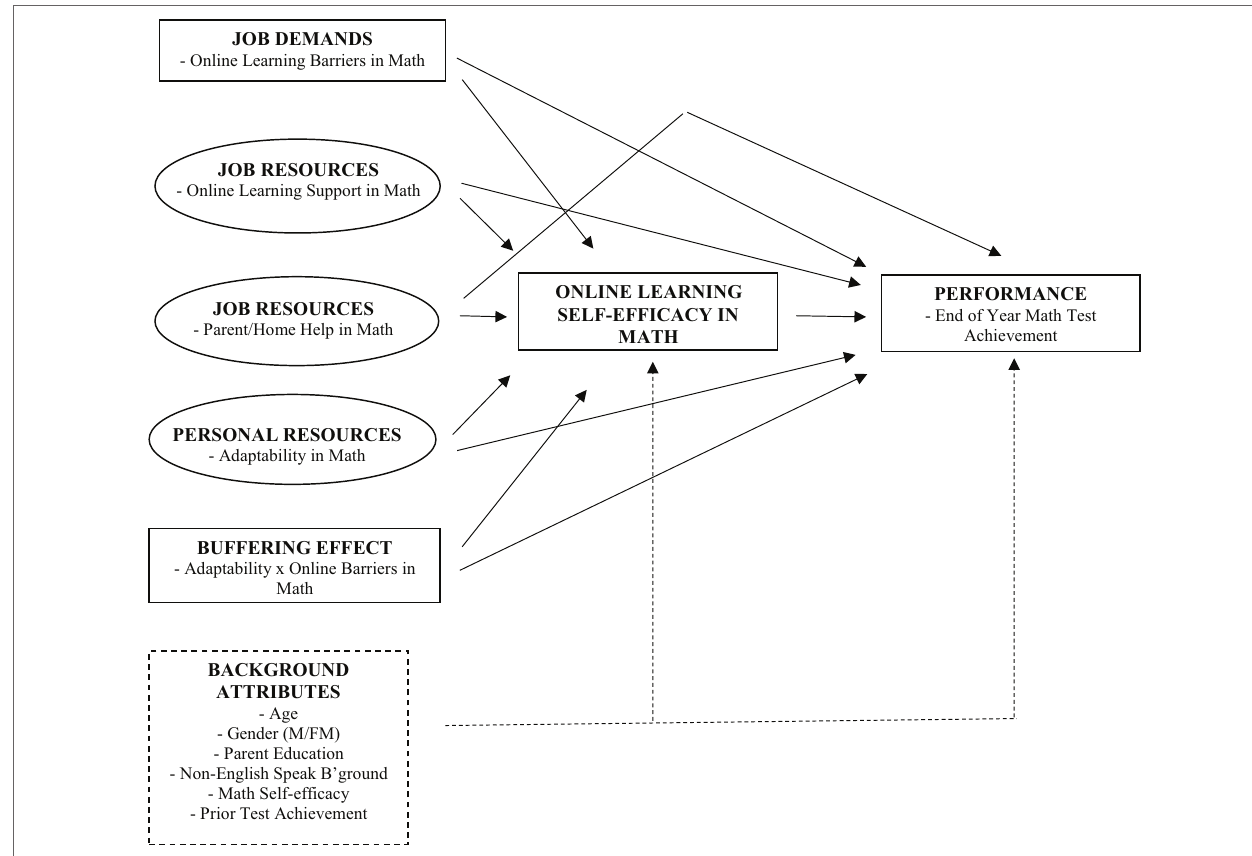
FIGURE 1 | Hypothesized JD-R process in online